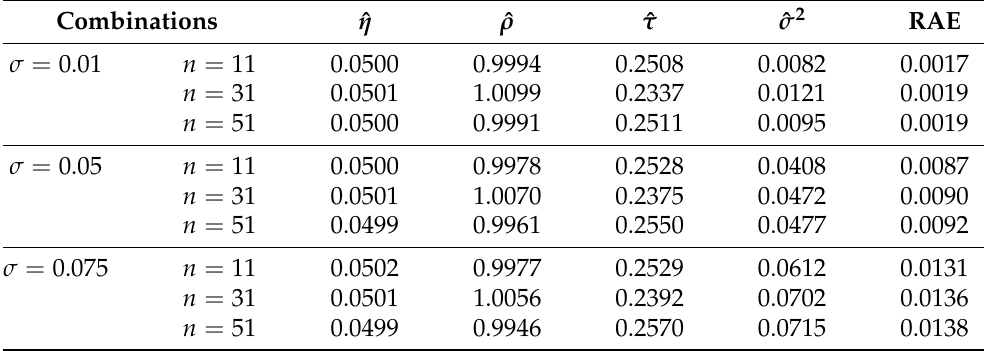
Figure 2. Observed mean vs. estimated mean obtained from simulated sample paths with the estimated parameters, for the case of a hyperbolastic process of type I. Table 1. Final solutions for simulated data of the H 1 process and RAE to estimated mean. Original parameters are η = 0.05, ρ = 1, and τ =